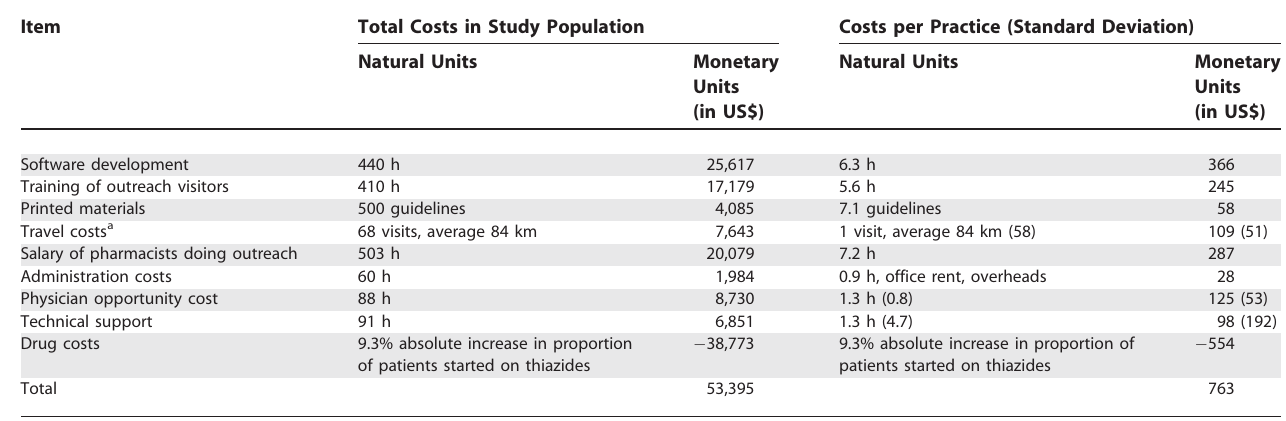
Table 4. Costs Related to the Intervention